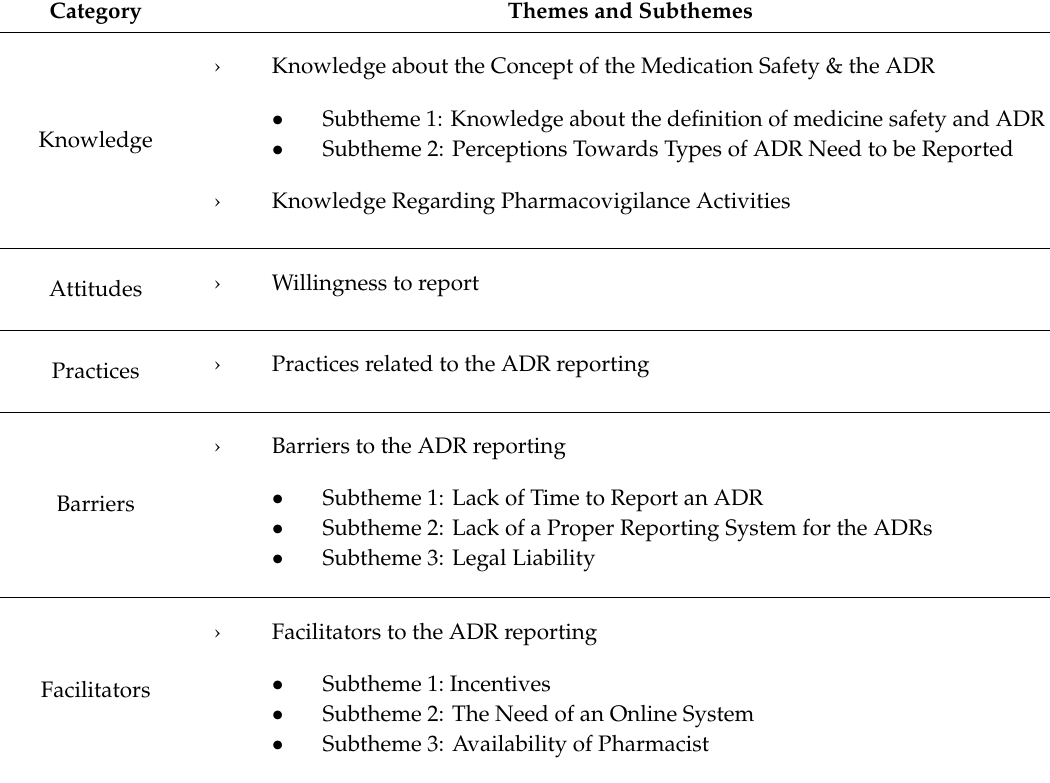
Table 3. Description of themes and